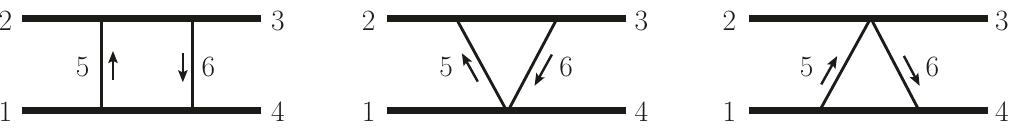
Figure 8 . The two particle cut at one loop containing classical potential. The blobs represent tree amplitudes and exposed lines are all on shell.